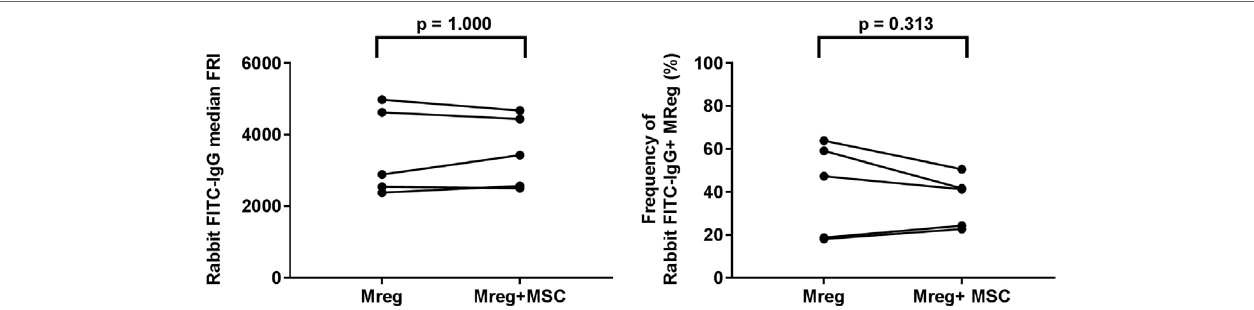
FigUre 5 | Effect of MSC coculture on the phagocytic ability of Mreg. The phagocytic ability of Mregs was assessed using latex beads coated with FITC-labeled rabbit IgG. The median FRI (left panel) and frequencies of positive cells (right panel) were determined with flow cytometry analysis. The variations between Mreg with and without MSC coculture were analyzed by the Wilcoxon matched-pairs signed-rank test. The number of biological replicates is 5. Abbreviations: FRI, fluorescence intensity; IgG, immunoglobulin G; Mreg, regulatory macrophage; MSC, mesenchymal stromal cell.